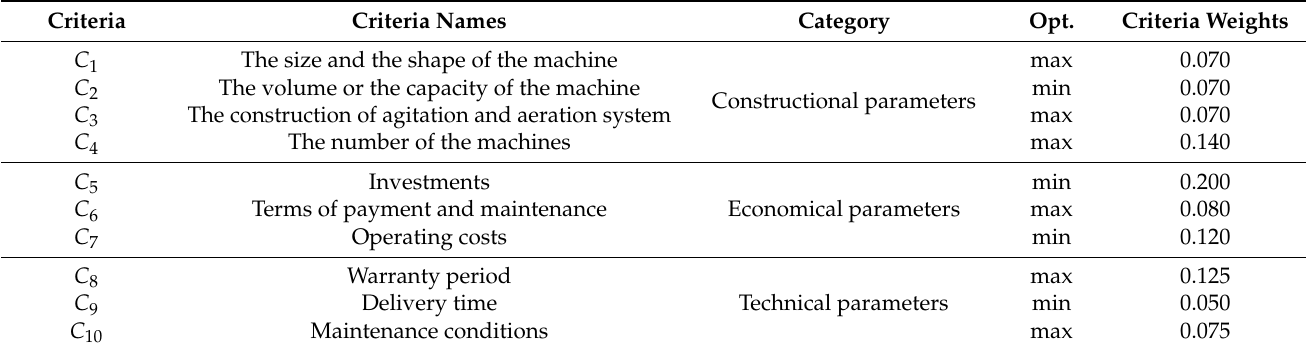
Table 14. The evolutional criteria and criteria weights.